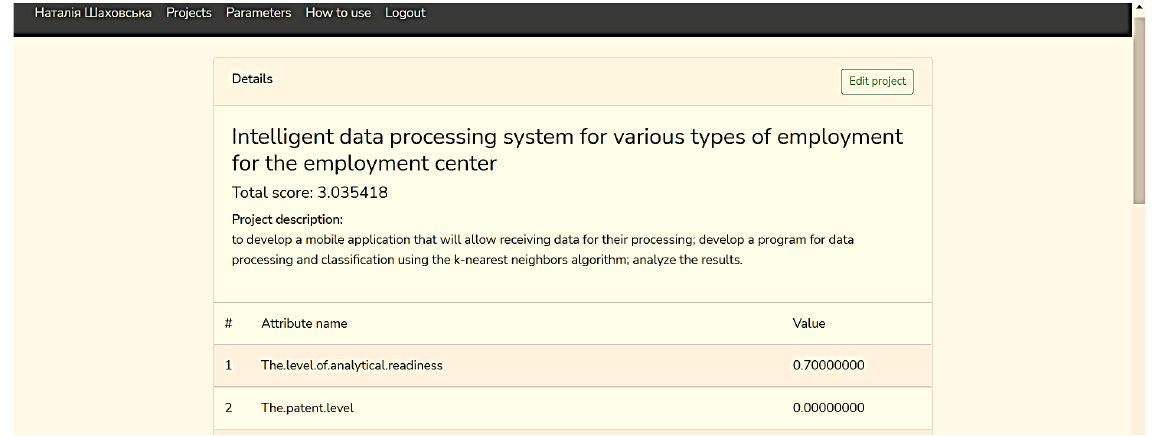
Figure 10. Webpage for product editing.